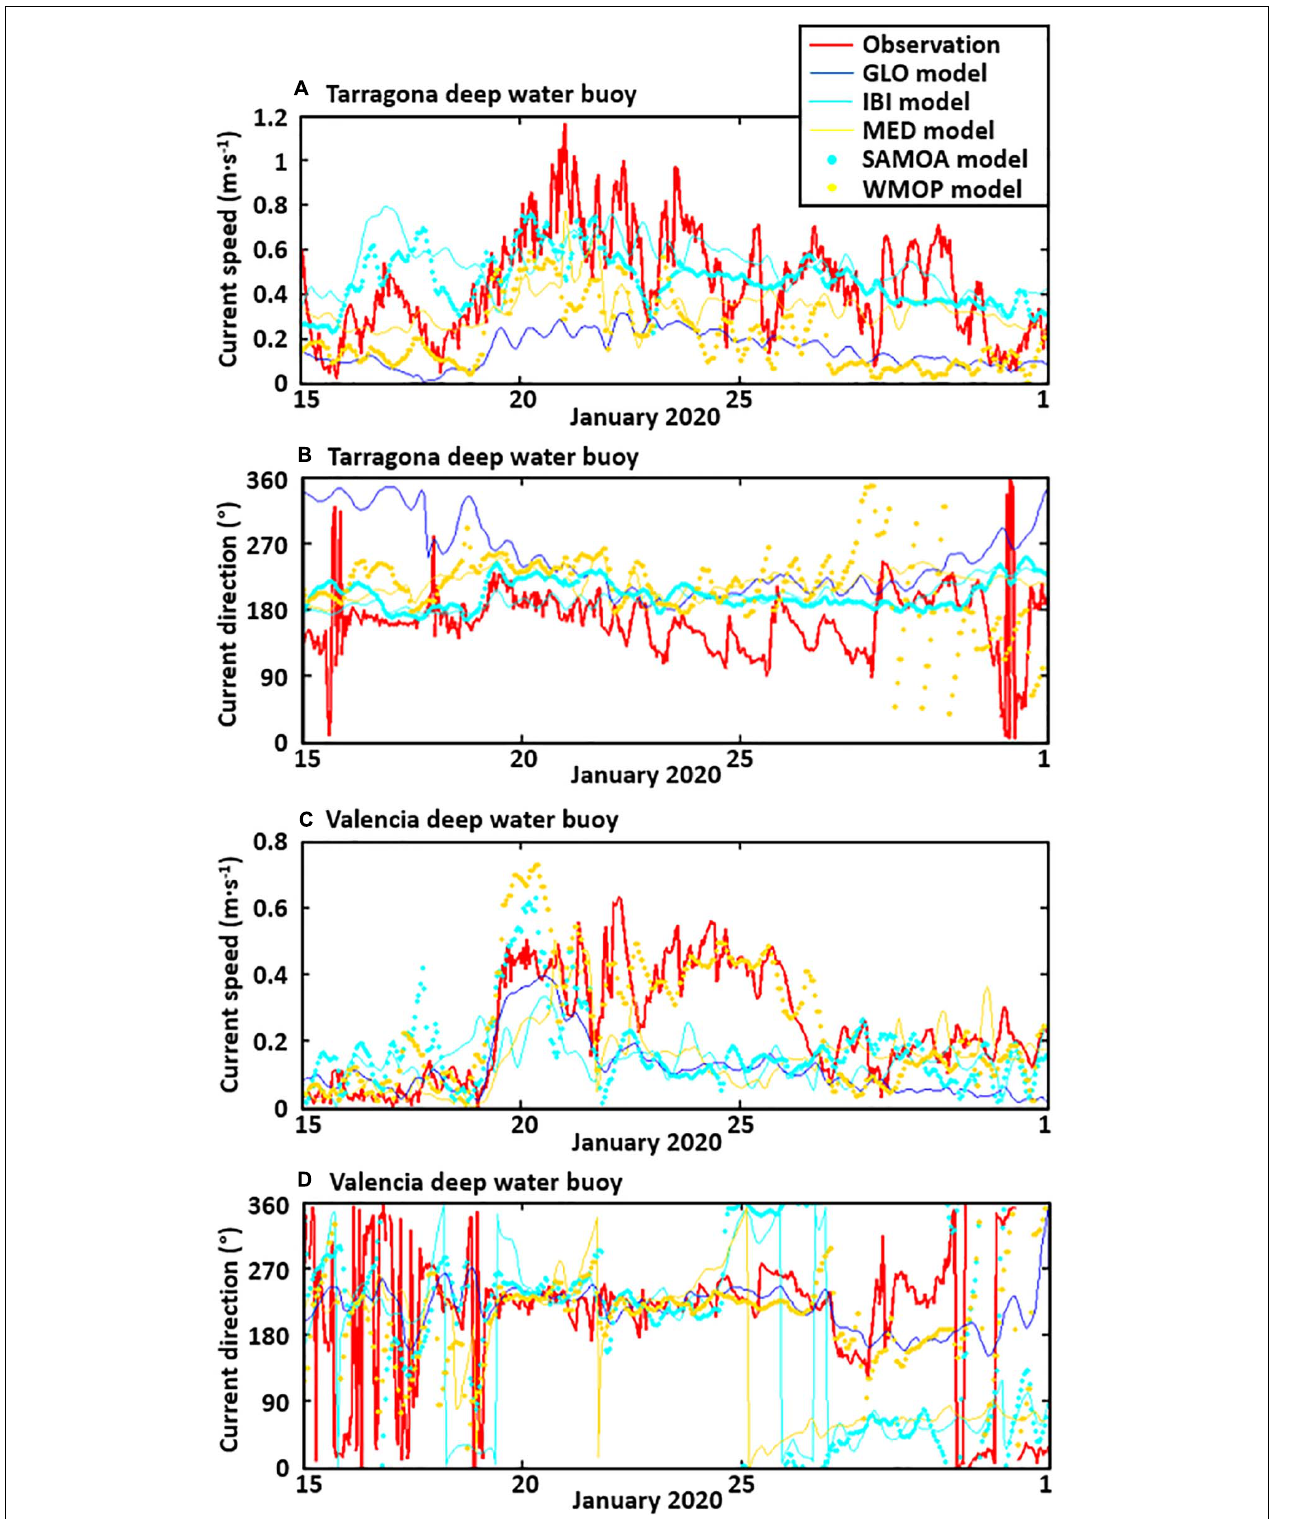
FIGURE 5 | Validation of operational ocean models with in situ observations buoys: Timeseries of surface current [speed (in ms − 1 ) and direction (deg)] at Tarragona ( A,B , respectively) and Valencia (C,D) moorings. Observed and simulated (by the five model services: CMEMS GLO, IBI, MED, and SOCIB WMOP and PdE SAMOA) timeseries